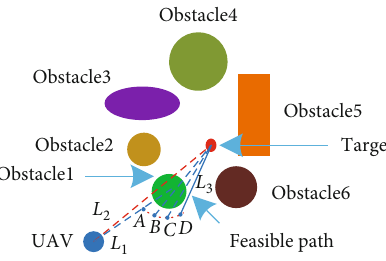
Figure 7: Example 2: the parallel search strategy for UAV when the goal is unreachable. Obstacle4